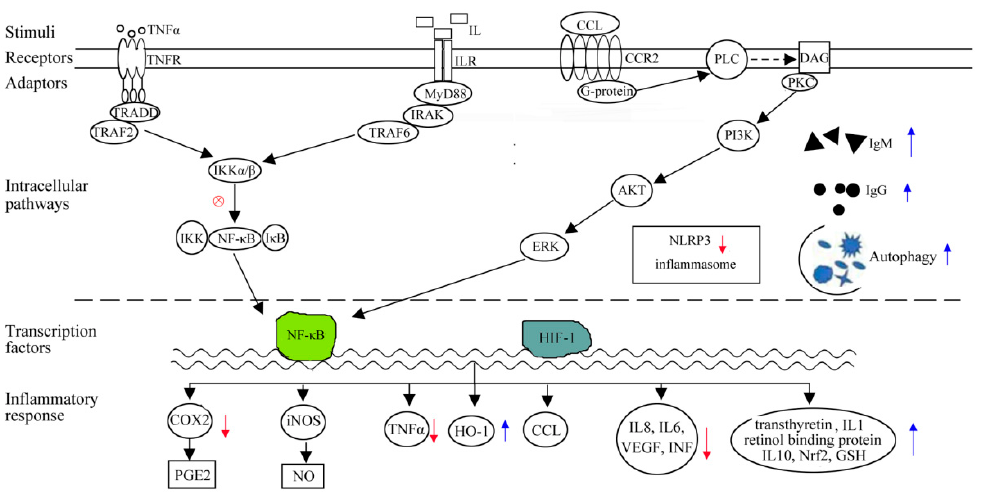
Figure 2. Schematic illustrating the immunomodulation mechanisms of GTPs and EGCG through anti-inflammatory mechanism.